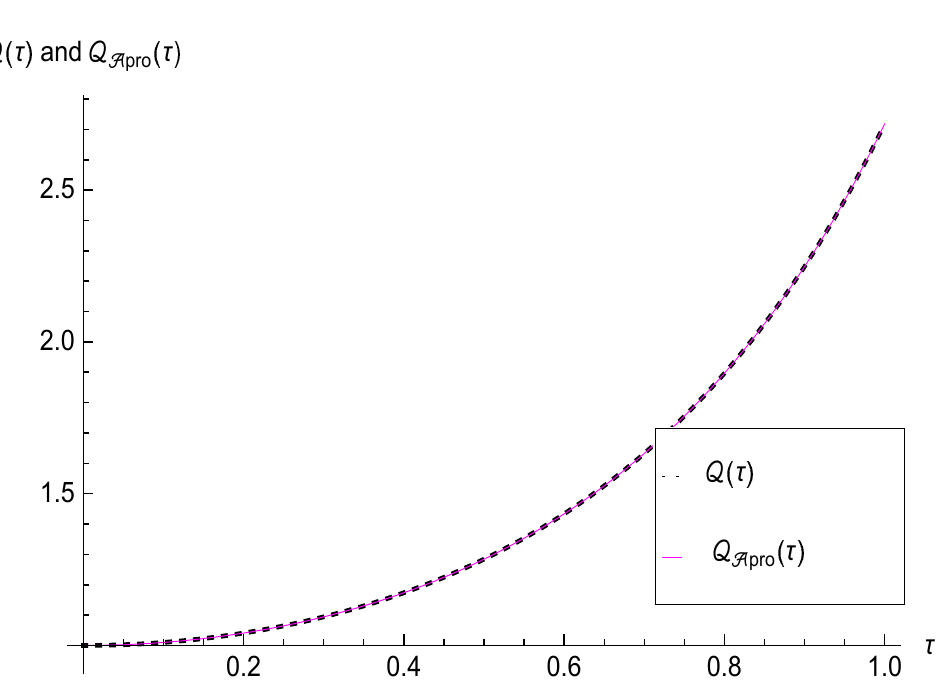
Figure 3. Curves of the exact and numerical solutions of Q ( τ ) of the problem (30), where σ 1 = (cid:36) 1 = σ 2 = (cid:36) 2 = 0, ν = 0.5 and N = M = 16.